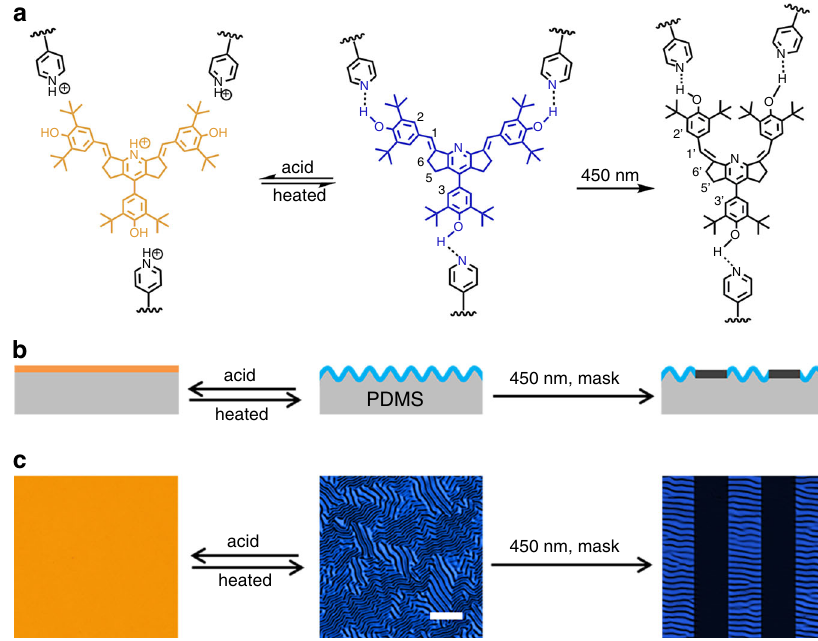
Fig. 1 Strategy for the production of the dynamic wrinkled pattern with tunable fl uorescence. a Chemical structure of P4VP-nBA-S/DSP-OH served as the top layer and the protonation and photoisomerization reaction during the evolution process of winkled and fl uorescent pattern. b Schematic illustration of the dual pattern with tunable wrinkle and fl uorescence in response to visible light and acid based on (P4VP-nBA-S/DSP-OH)/PDMS bilayer system. c Corresponding laser scanning confocal microscope (LSCM) images of wrinkled surface with fl uorescence color responsive to visible light and acid. Scale bar: 100 μ m.